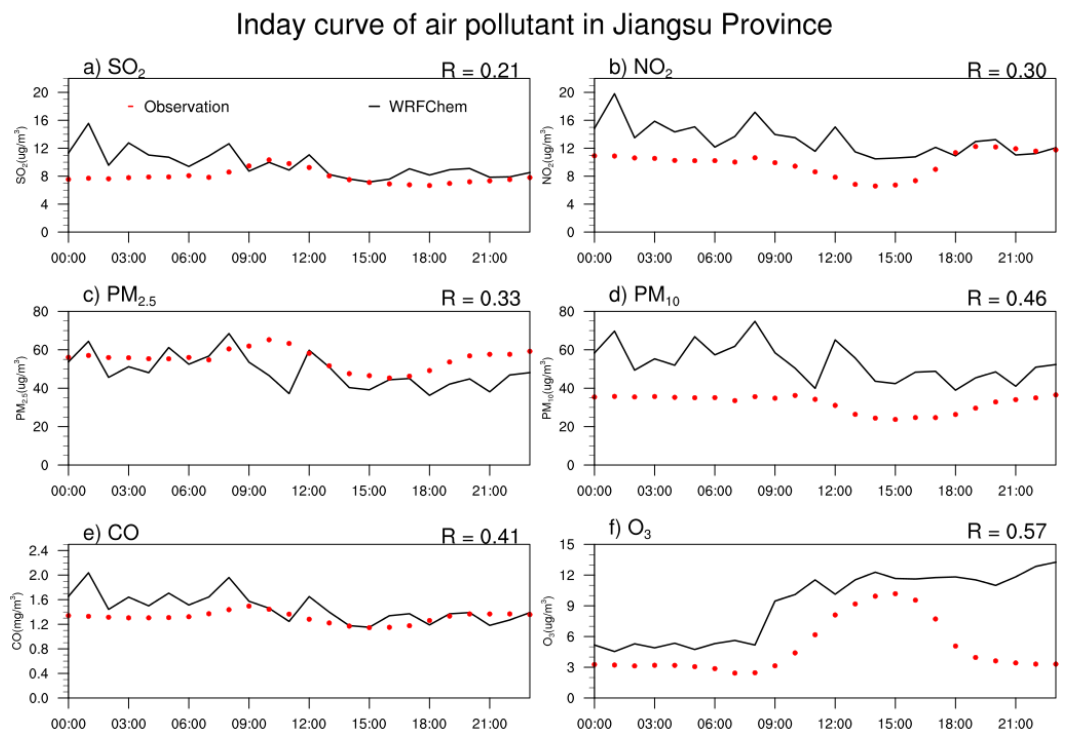
Figure 9. Diurnal variation curves of SO 2 , NO 2 , PM 2.5 , PM 10 , CO, and O 3 obtained from observation and WRF-Chem modulation. The R thresholds of passing 90% and 95% confidence tests are 0.33 and 0.388, respectively.